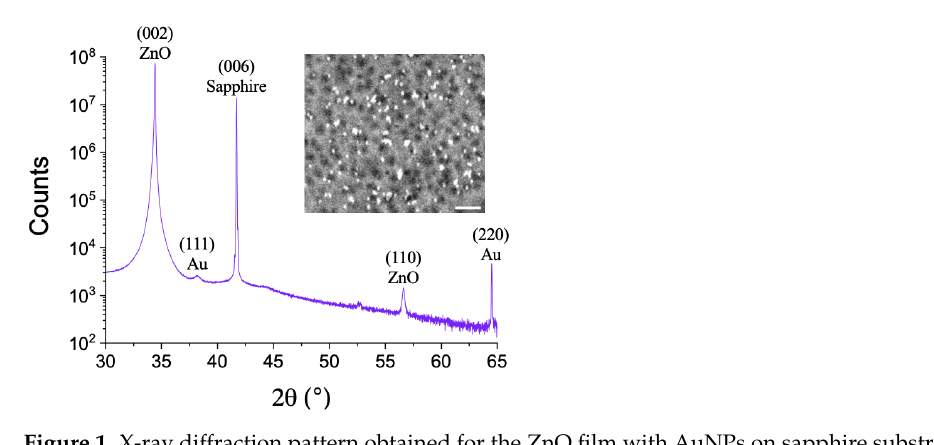
Figure 1. X-ray diffraction pattern obtained for the ZnO film with AuNPs on sapphire substrate (see SEM image in the inset, and white bar = 300 nm).